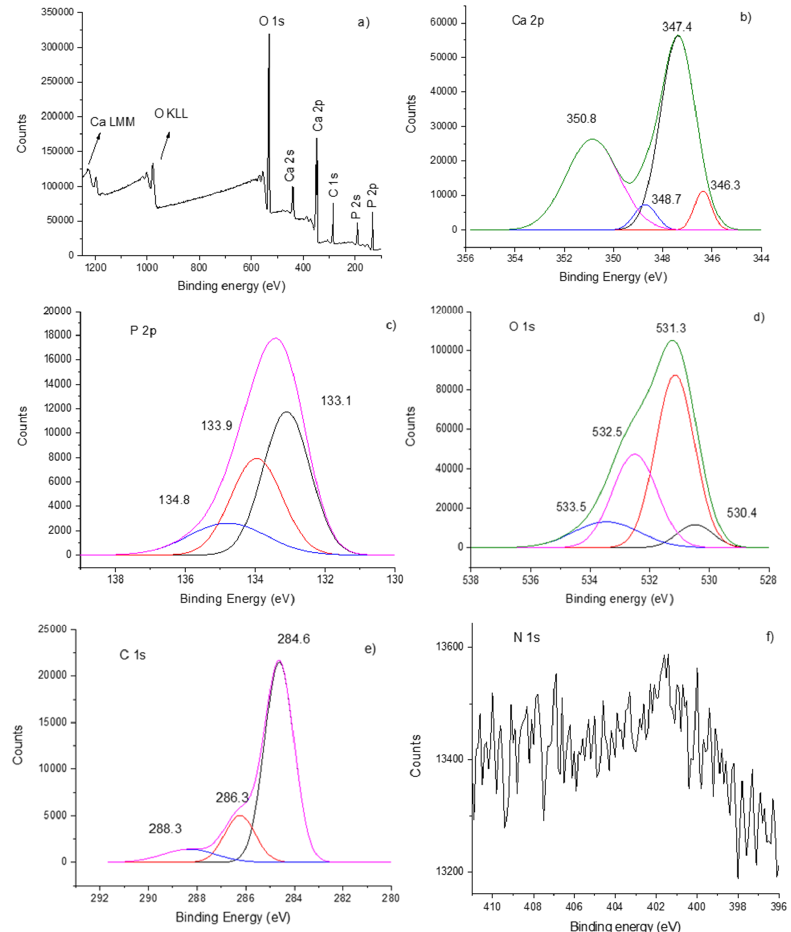
Figure 3. XPS data of HApCs coatings deposited on Si substrates at 5 × 10 −3 mbarr Ar gas working pressure: ( a ) survey spectrum; ( b ) Ca 2p; ( c ) P 2p; ( d ) O 1s; ( e ) C1s; and ( f ) N 1s high-resolution lines.